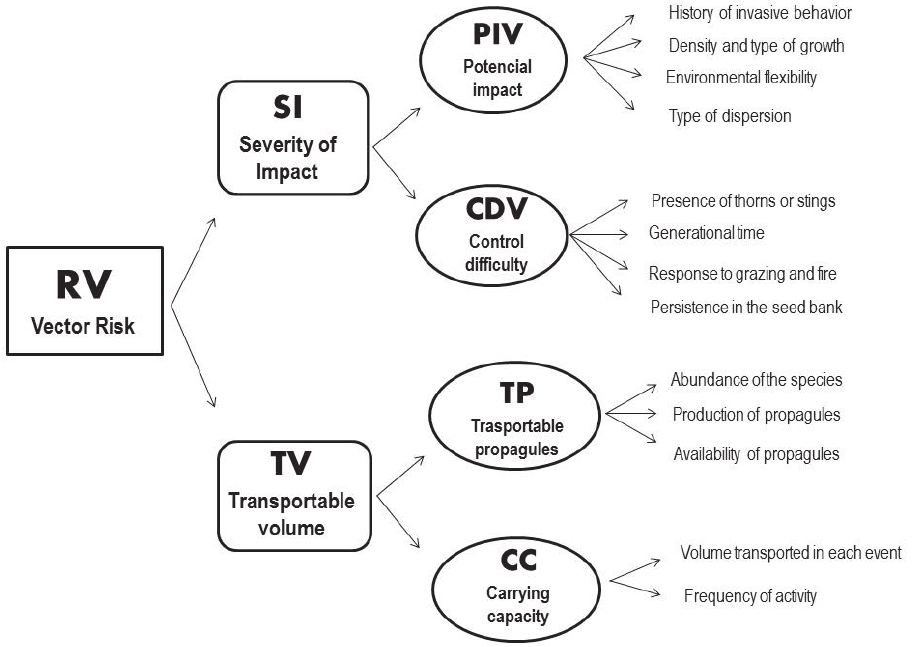
Figure 1. Vector analysis schema. Diagram of the analysis of the relative importance of vectors associated with the introduction and dispersal of invasive alien plants in Ernesto Tornquist Provincial Park (Buenos Aires,